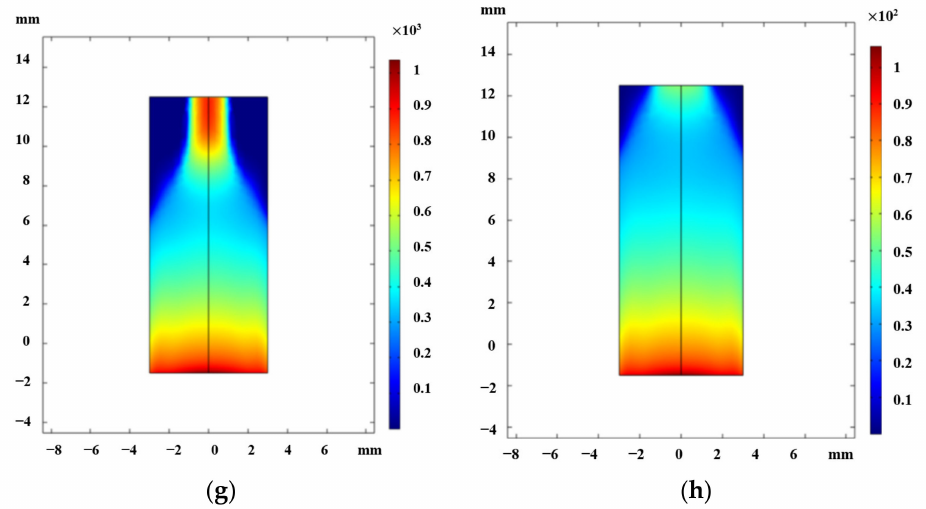
Figure 6. Electrical conductivity distribution cloud charts. ( a ) t = 1 µ s; ( b ) t = 5 µ s; ( c ) t = 9 µ s; ( d ) t = 13 µ s; ( e ) t = 17 µ s; ( f ) t = 23 µ s; ( g ) t = 27 µ s; ( h ) t = 31 µ